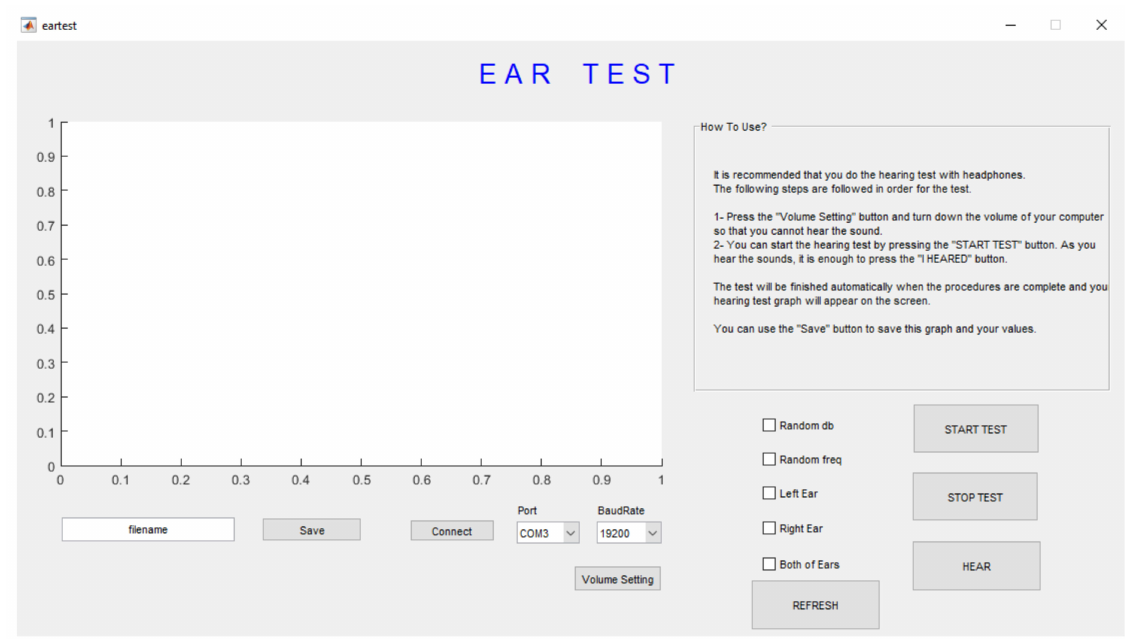
Figure 3. The designed hearing test interface start screen in the